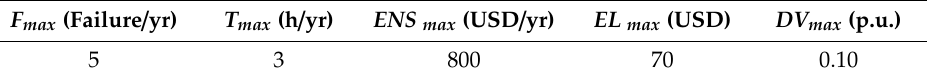
Table 6. Maximum value of reliability indices obtained using optimal